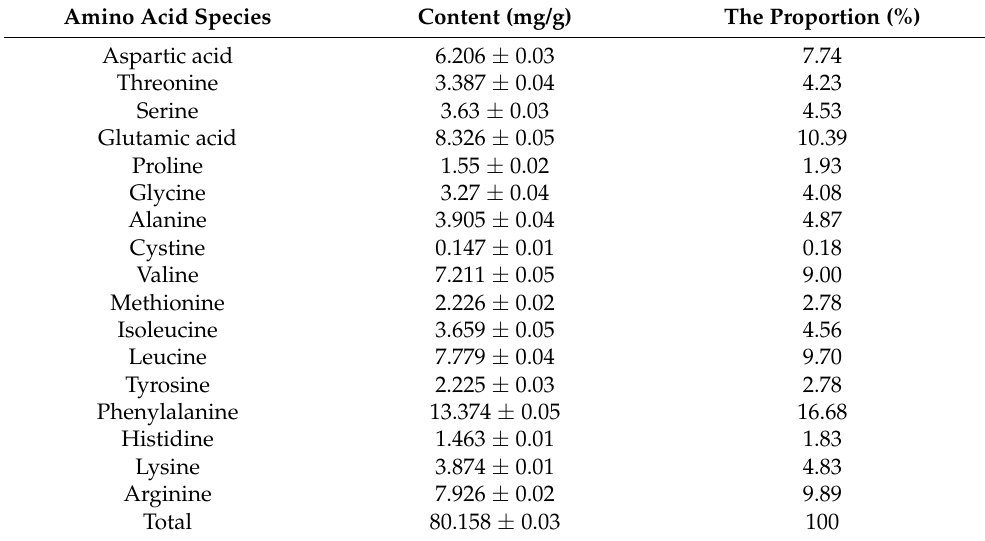
Table 3. The composition and content of hydrolyzed amino